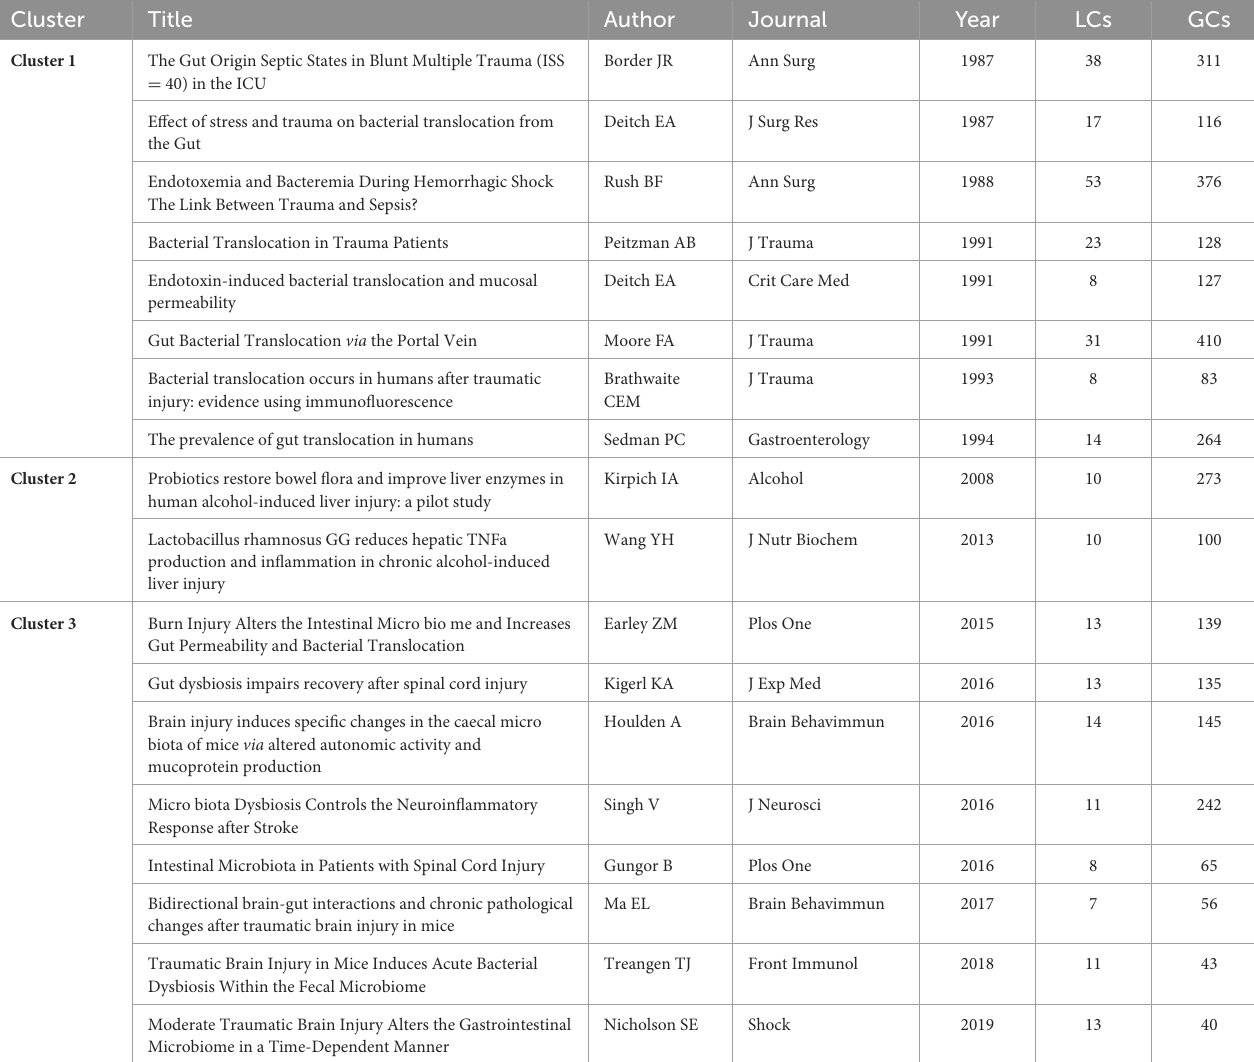
TABLE 5 Articles in historical direct citation network.